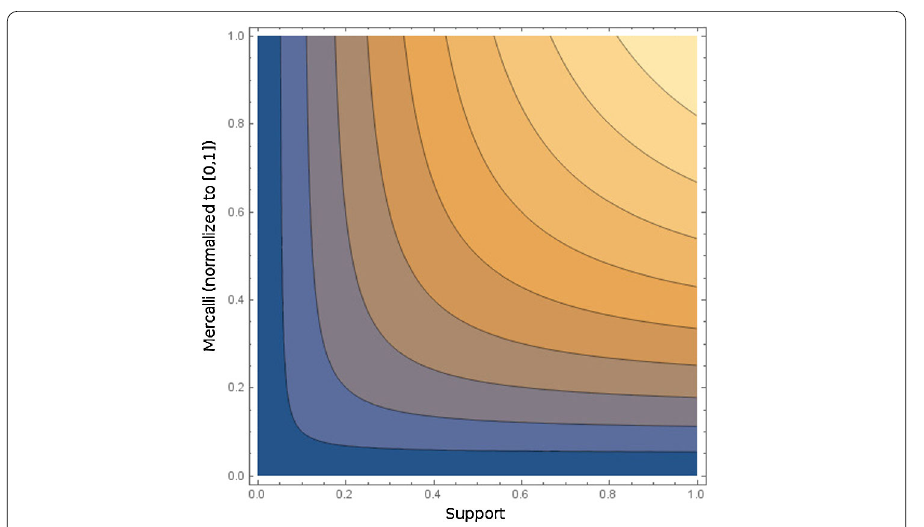
Figure 3 The reinforced Mercalli support function. The reinforcedMercallisupport function depicted using contour levels. Low energy events or events with low support are filtered by the function. Medium